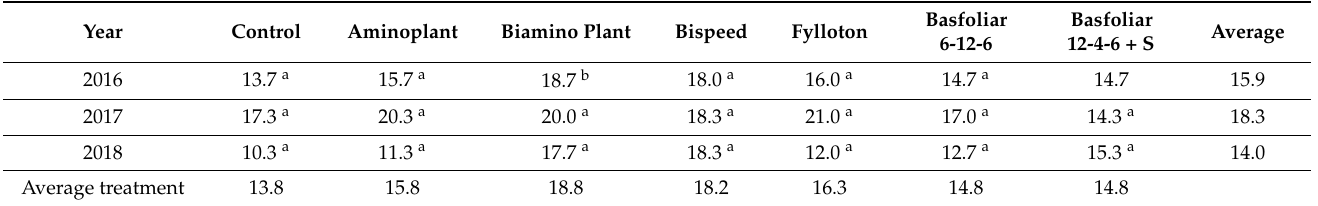
Table 3. The number of M.9 rootstock stoolings from one mother plant depending on the tested treatments.